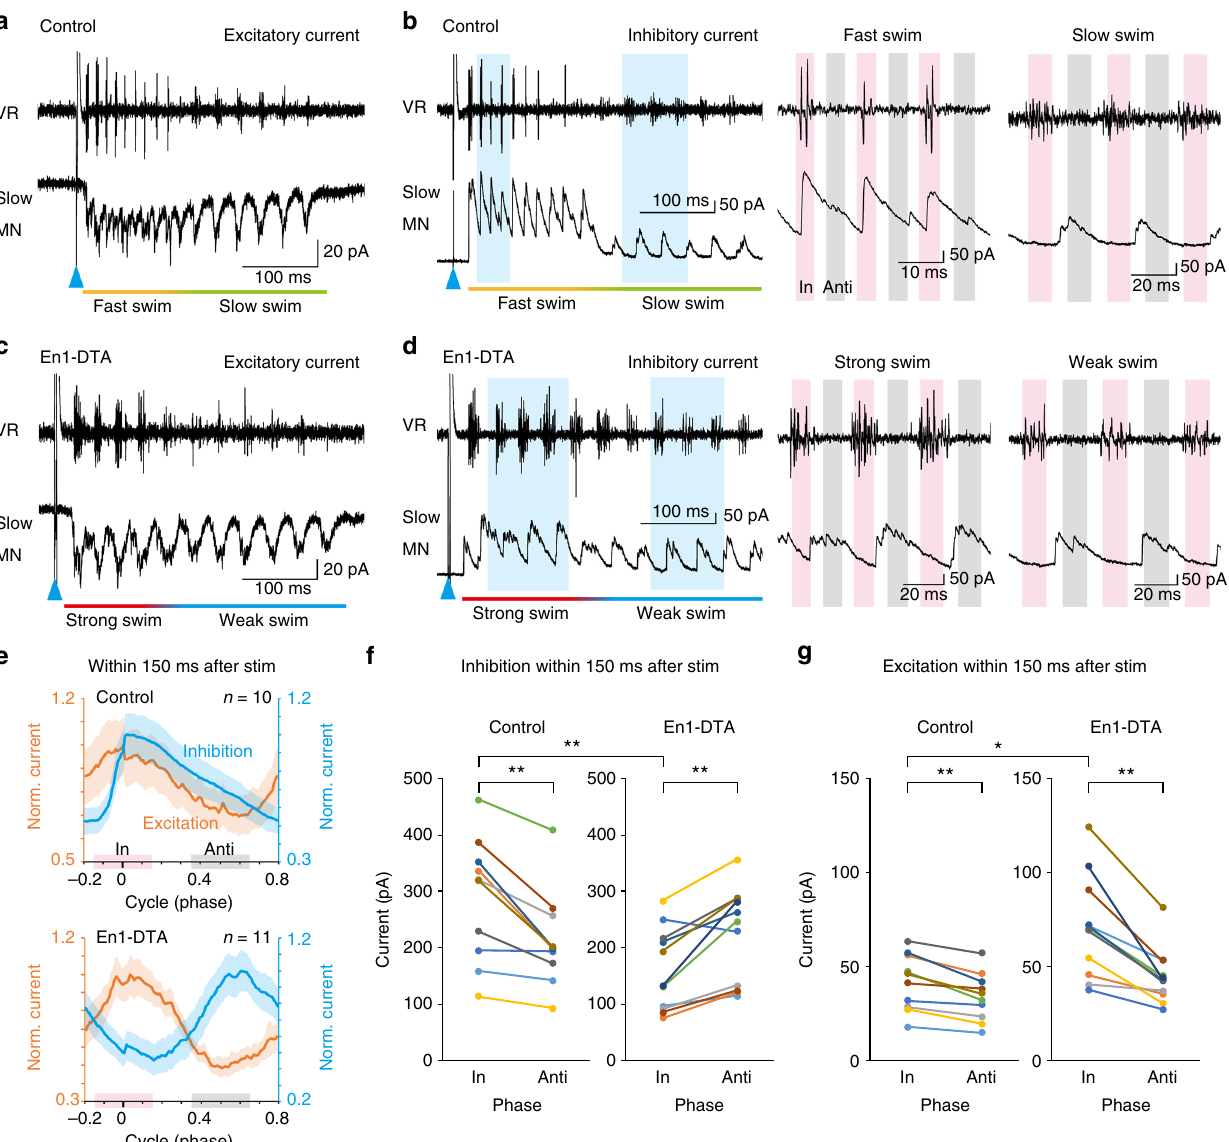
Fig. 4 Voltage-clamp recordings from slow-type motoneurons (MNs) in control and En1-DTA fi sh. a Example of simultaneous recordings between slow- type MNs (voltage-clamp) and ventral root (VR) in control fi sh. The cell was held at − 75 mV to reveal excitatory currents. b Example of simultaneous recordings between slow-type MNs and VR in control fi sh. The cell was held at + 10 mV to reveal inhibitory currents. The right two panels show the enlargements of the regions shaded in blue. “ In ” represents the in-phase period (from − 0.15 to + 0.15 in the cycle, pink). “ Anti ” represents the anti-phase period (from 0.35 to 0.65, gray). c Example of simultaneous recordings between slow-type MNs and VR in En1-DTA fi sh. The cell was held at − 75 mV to reveal excitatory currents. d Example of simultaneous recordings between slow-type MNs and VR in En1-DTA fi sh. The cell was held at + 10 mV to